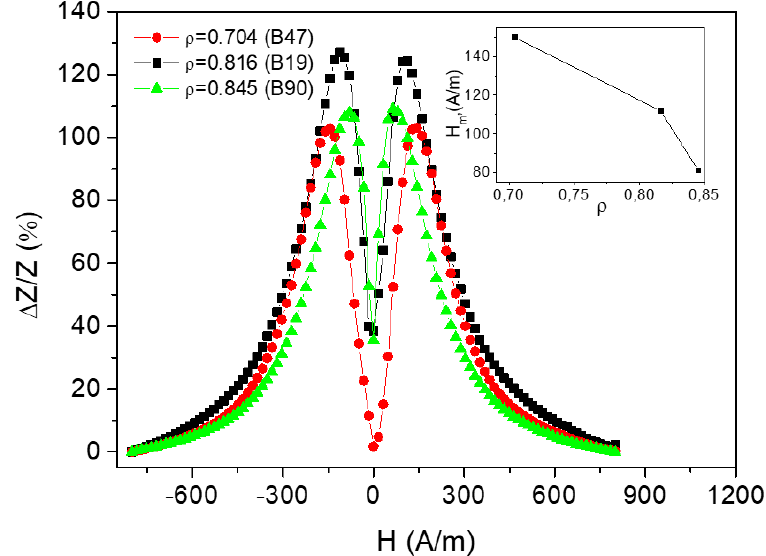
Figure 11. Effect of the sample geometry on magnetic field dependence of giant magnetoimpedance effect (GMI) ratio of microwires № 4. Reprinted with permission from [19].